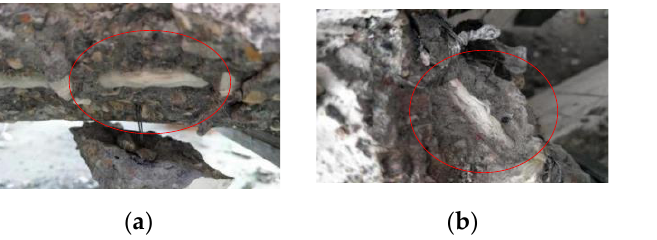
Figure 7. Observed damage of GFRP. ( a ) Outer rubber layer failure (BC-9); ( b ) Fiber bundle breakage (BC-3).